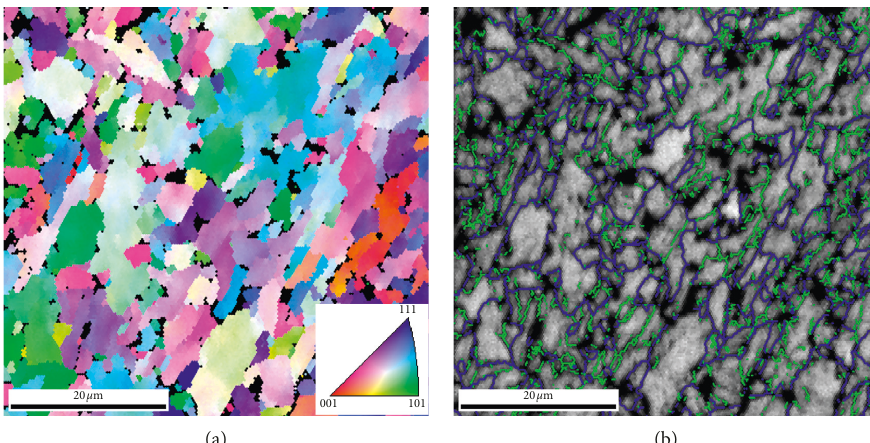
Figure 3: (a) Inverse pole figures and (b) boundary misorientation maps of the ferrite phase and phase distribution maps obtained from EBSD measurement of Bend C.